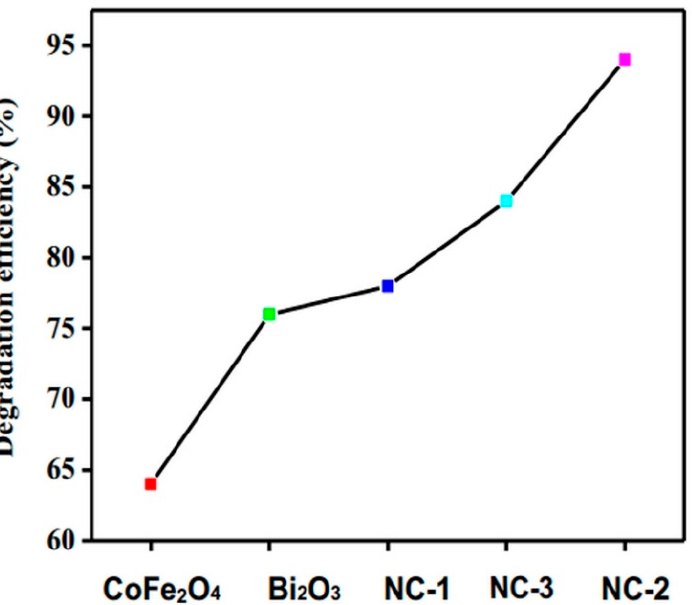
Figure 7. Comparison of percentage efficiency of all prepared photocatalysts for methyl orange deg- radation. Table 3. Absorbance values of dye solutions charged by various as-prepared photocatalysts during photodegradation experiment in comparison to blank.